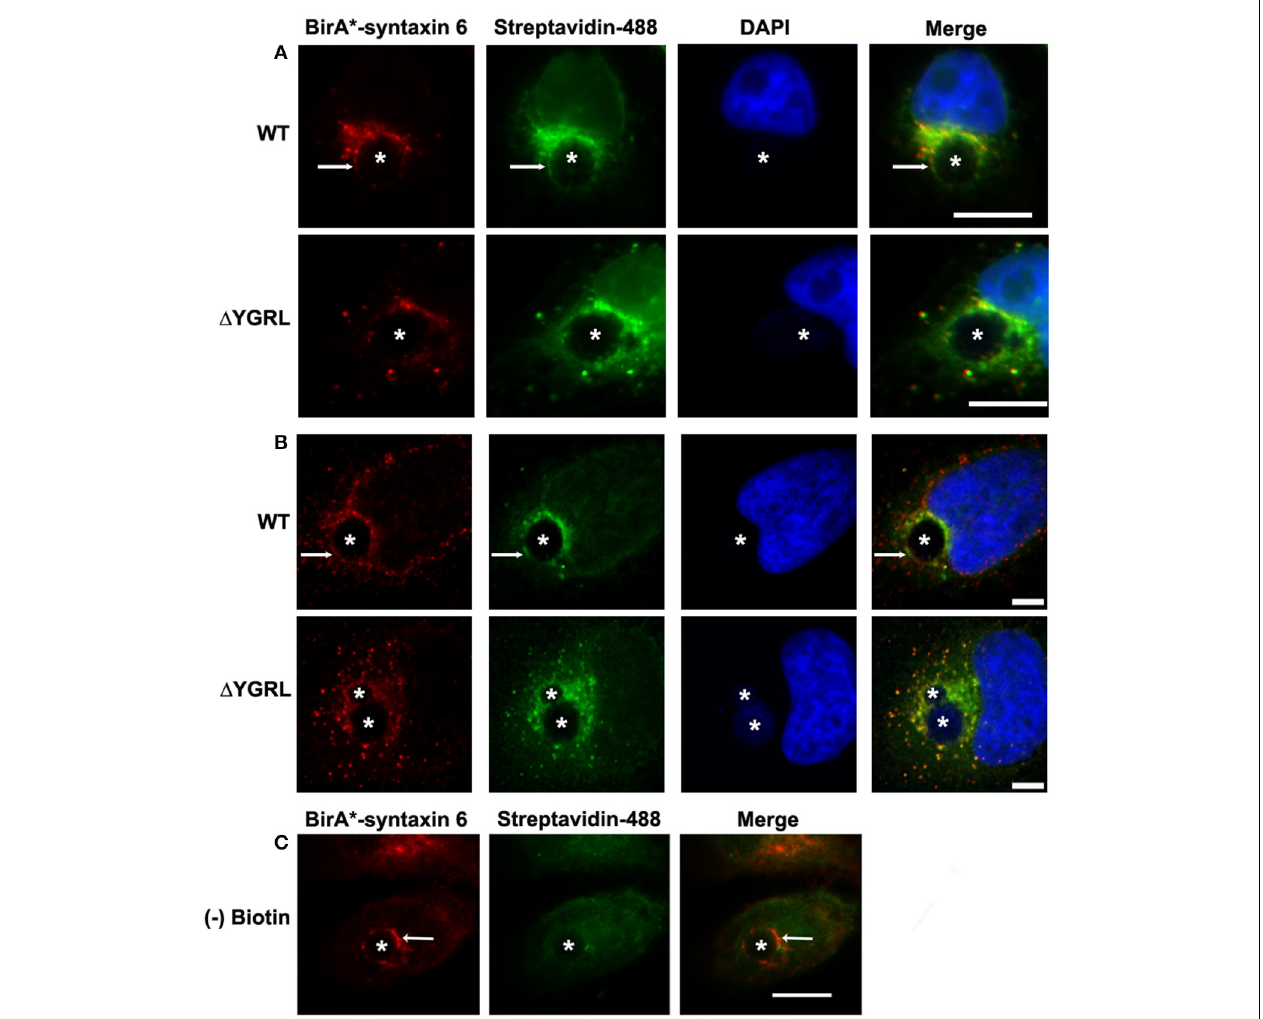
fluorescent scope (60 × magnification) (A,C) or an Olympus Fluoview 1000 Laser Scanning Confocal Microscope (B) . The cells were stained with DAPI to detect the chlamydial inclusion and nuclei (blue). Each image is representative of at least two independent experiments. White stars designate the chlamydial inclusion and white arrows denote colocalization of syntaxin 6 WT with the chlamydial inclusion. Bars, 10 μ m (A,C) or 5 μ m (B)